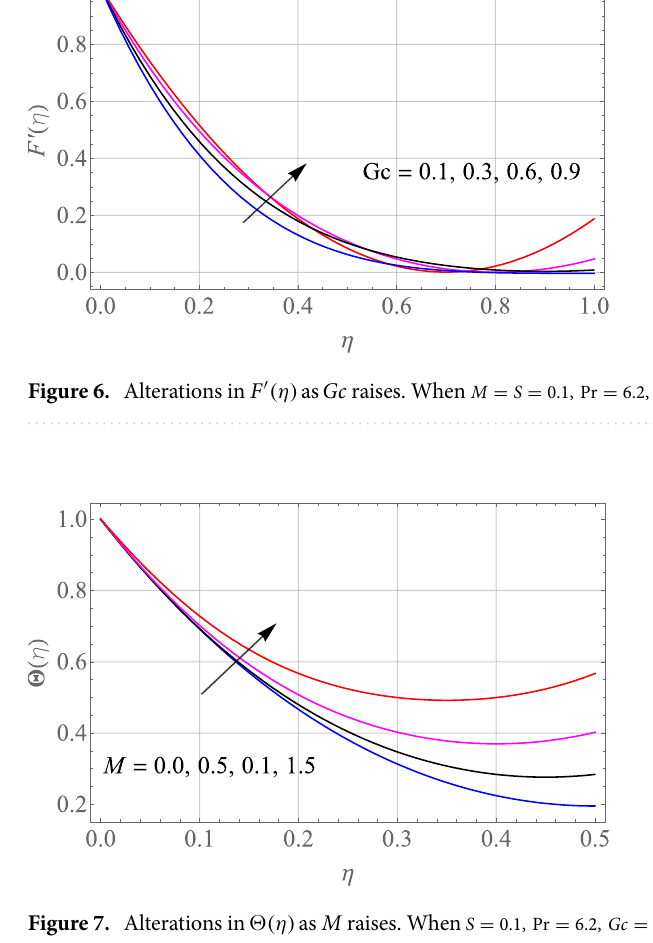
Figure 7. Alterations in �(η) as M raises. When S = 0.1, Pr = 6.2, Gc = Gr = 0.2, Ec = 1, Nb = Nt = 0.3, Sc = 0.3 .